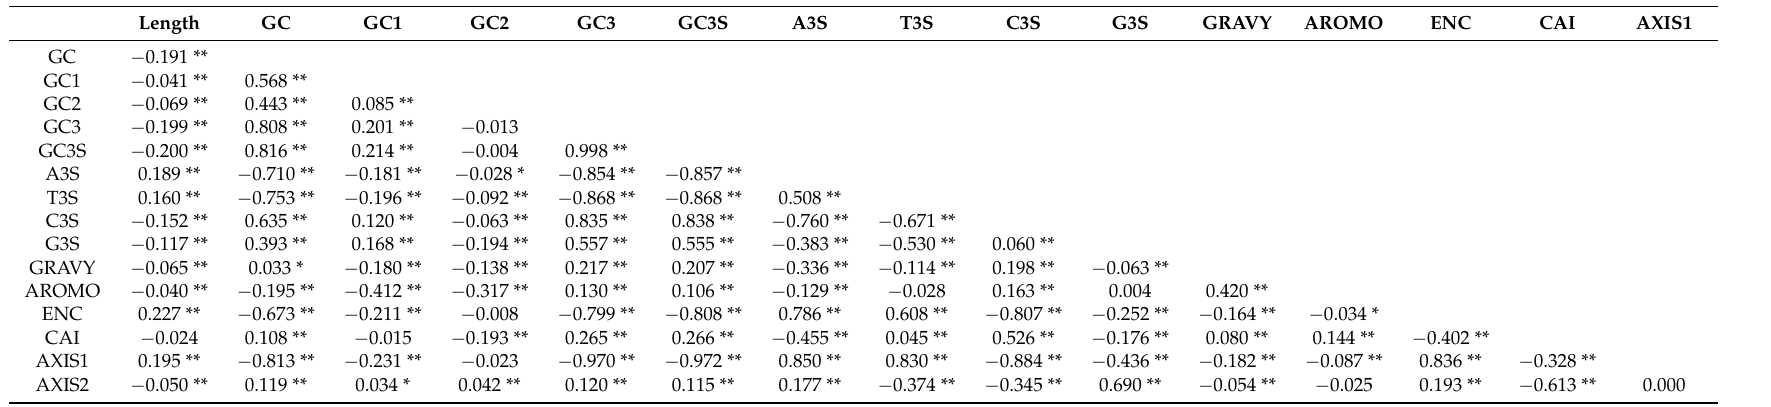
Table 2. Correlation coefficients between the positions of genes along the first two major axes with index of total genes’ codon usage and synonymous codon usage